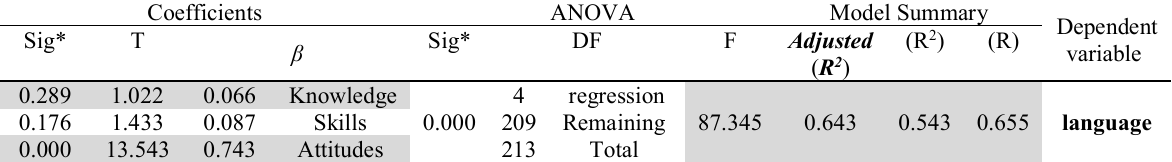
The results of the regression analysis between job competencies and